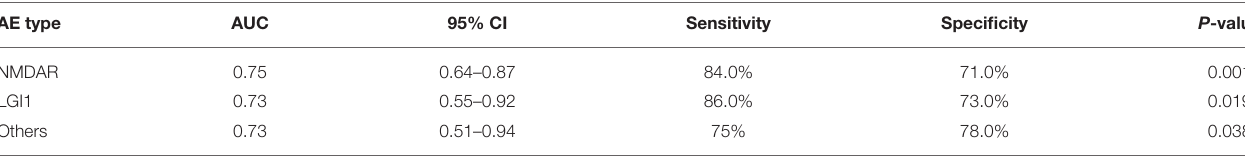
TABLE 3 | Predictive value of SII for treatment responses in different types of